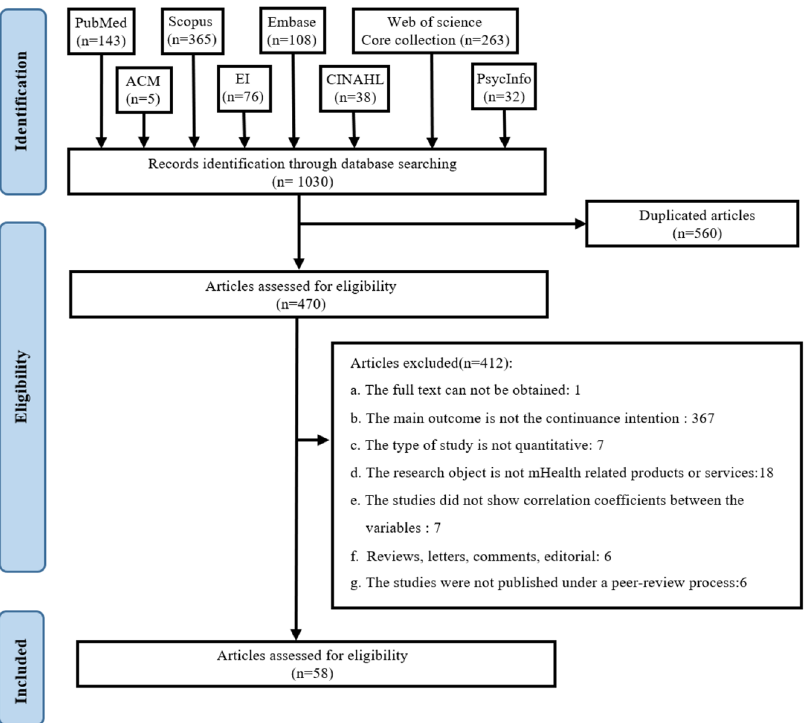
Fig. 1 Screening of studies included in the meta-analysis and systematic review. Using the Preferred Reporting Items for Systematic Reviews and Meta-Analyses as a screening process, a total of 58 studies were included in the